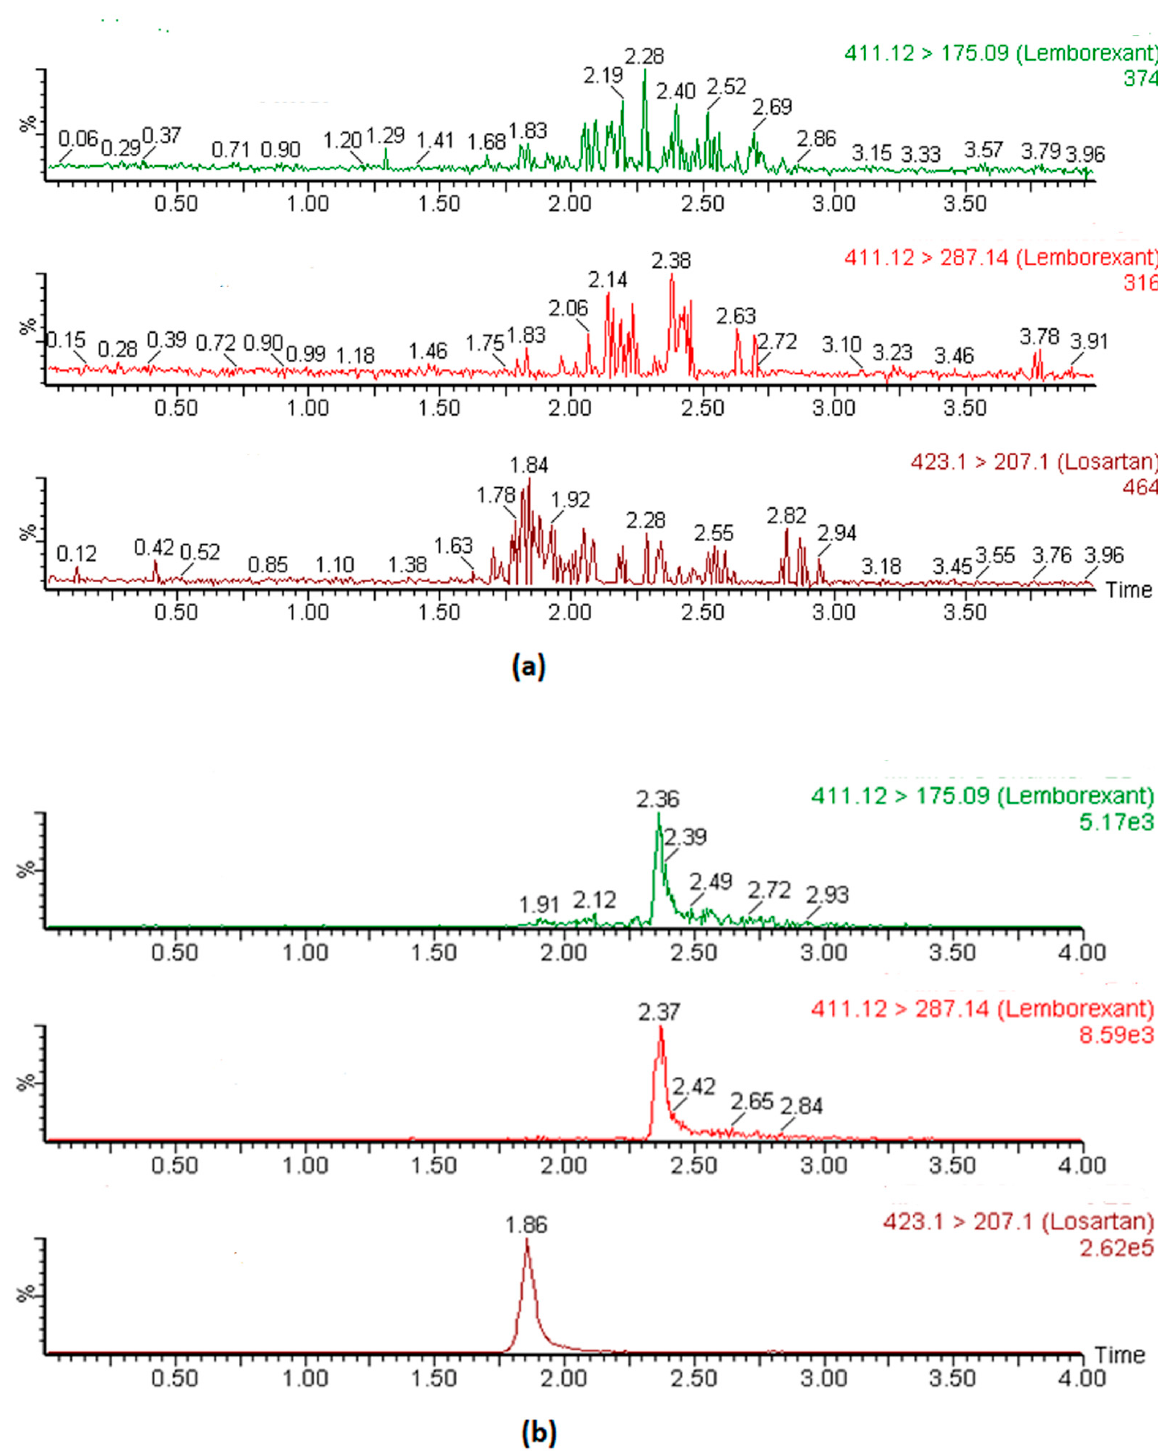
Figure 3. Representative MRM chromatogram of LEM and IS in blank plasma ( a ) and plasma fortified at LOQ level concentration ( b ). [411.12 > 175.09 → Qualifier ion; 411.12 > 287.14 → Quantifier ion; 423.1 > 207.1 → IS].